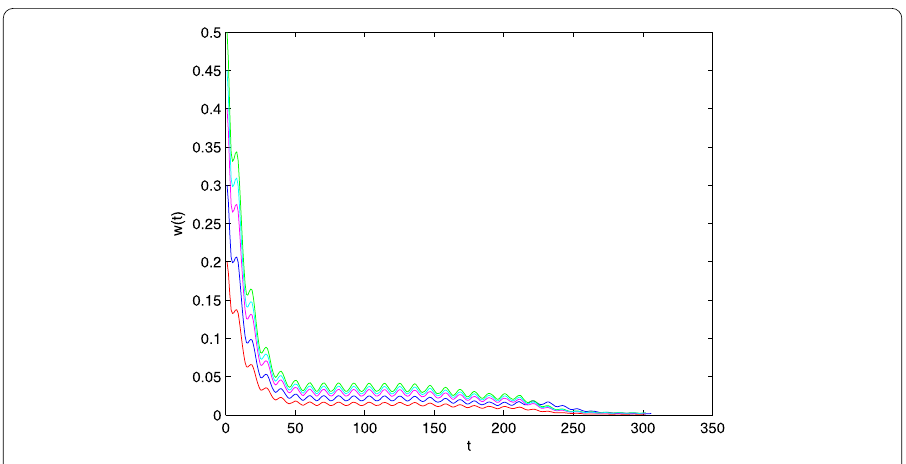
Figure 1 The relation of t and w ( t ). The initial values are w 0 =